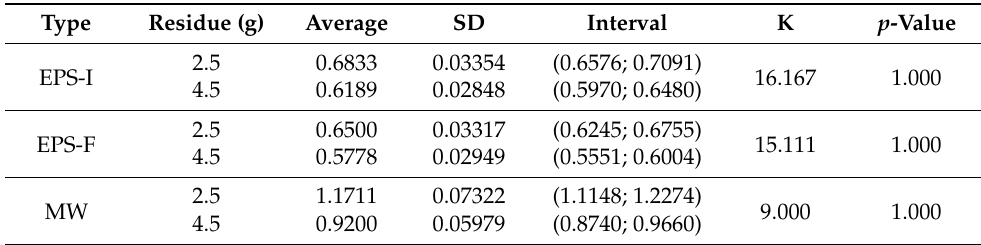
Table 6. Comparison for flexural strength (MPa) between mortars with incorporation of insulat- ing